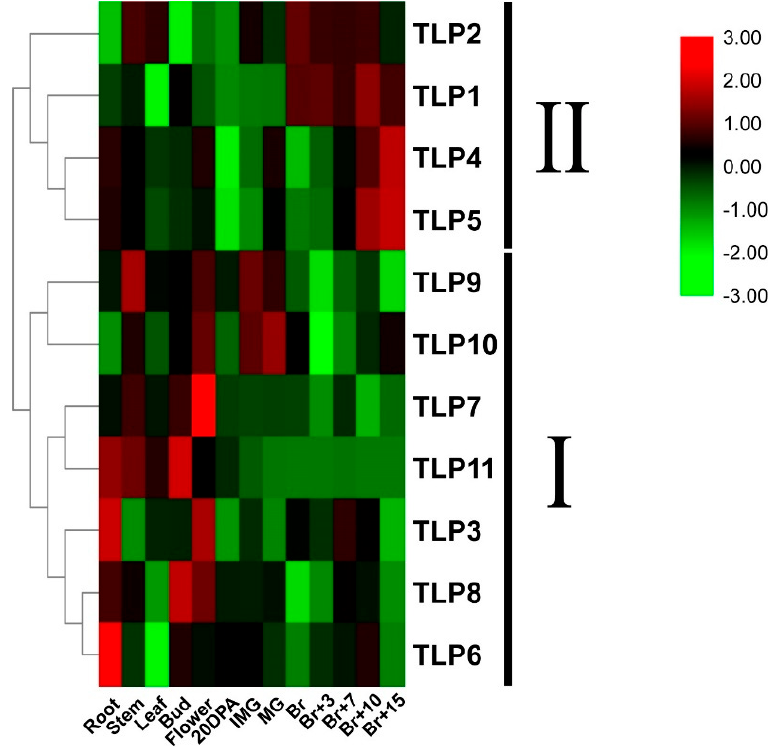
Figure 5. Expression of TLPs in different tissues of tomato (20DPA: Fruit at 20 days after anthesis; IMG: Immature green fruit; MG: Mature green fruit; Br: Breaker stage fruit; Br + 3: 3 days post-breaker; Br + 5: 5 days post-breaker; Br + 7: 7 days post-breaker; Br + 10: 10-day post-breaker; Br + 15: 15 days post- breaker).